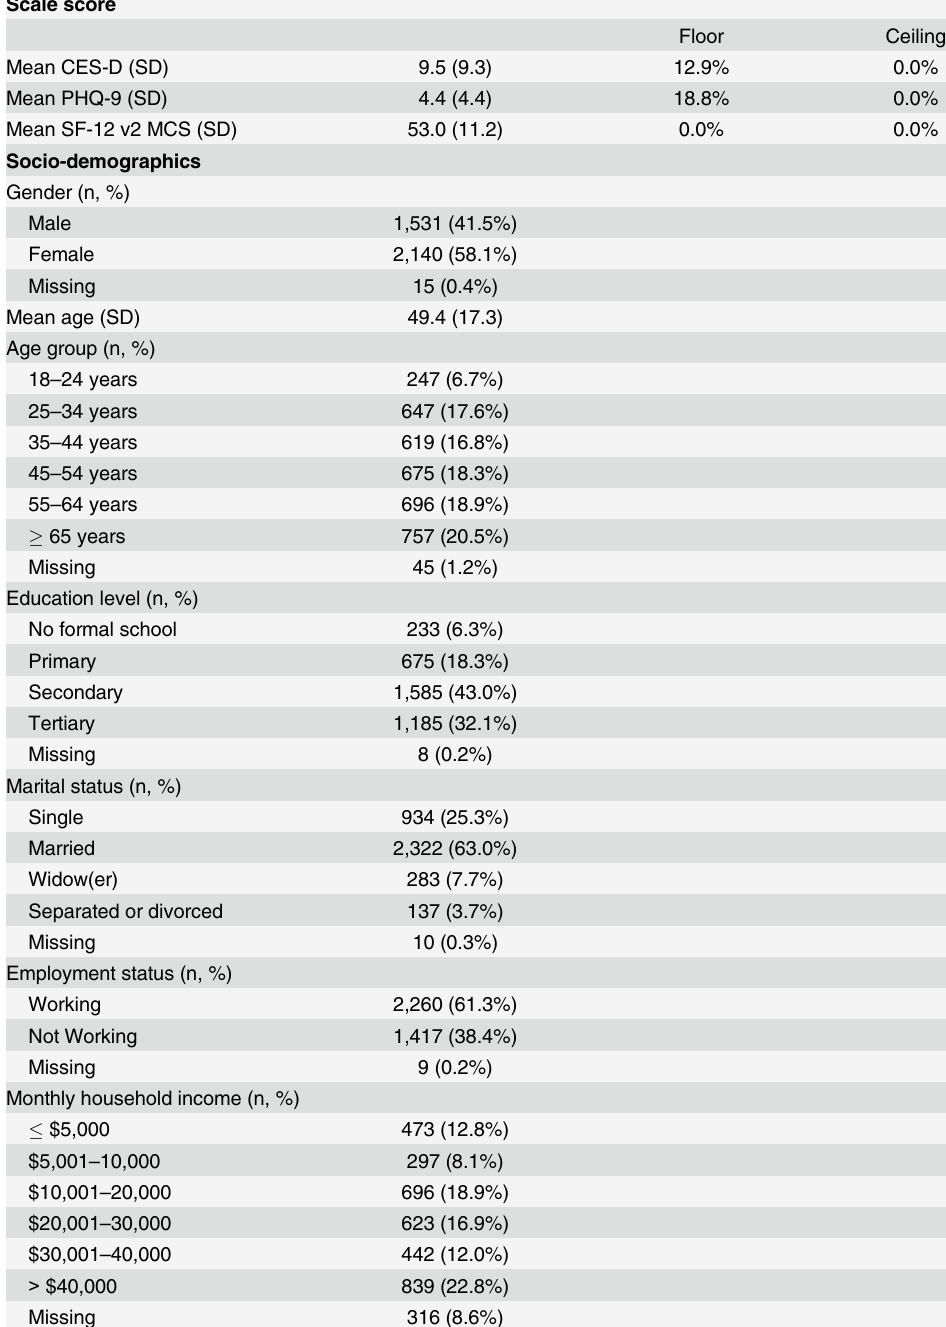
Table 1. Descriptive statistics of the CES-D, PHQ-9 and the SF-12 v2 MCS and Socio-demographic characteristics of study subjects (n =